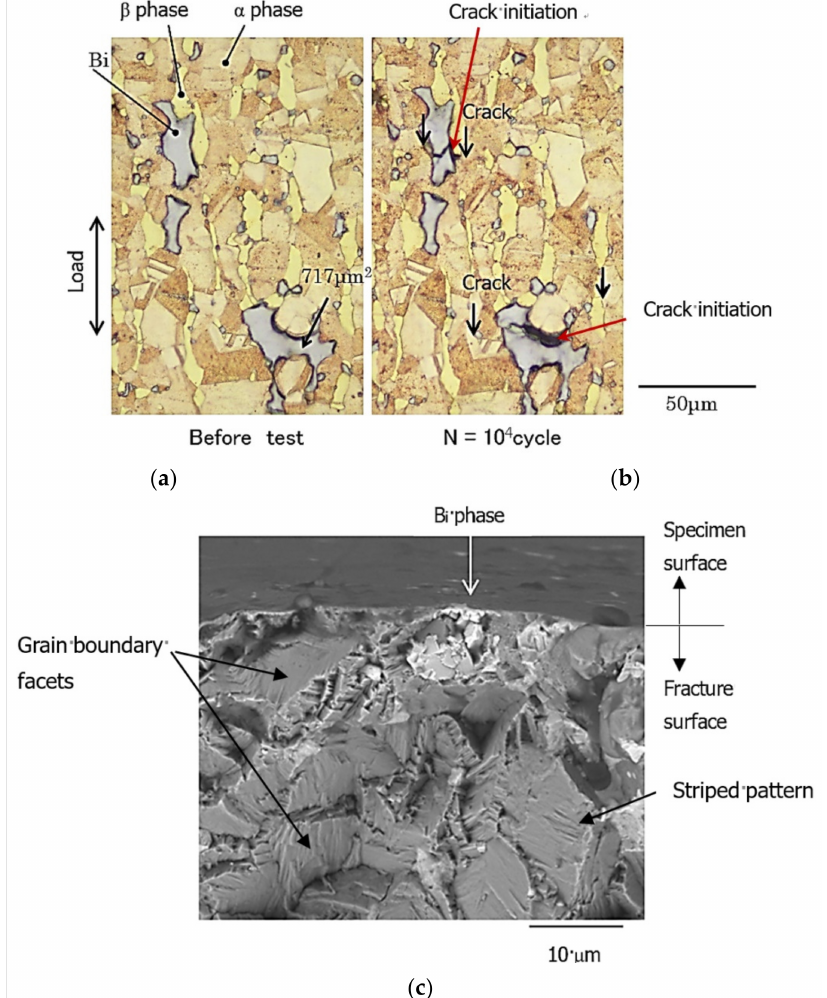
Figure 6. Fatigue crack initiation behavior observed in the Bi, A material’s surfaces at σ max = 330 MPa and R = 0.1: ( a ) specimen ( N = 0); ( b ) specimen ( N = 10 4 cycles); and ( c ) fracture